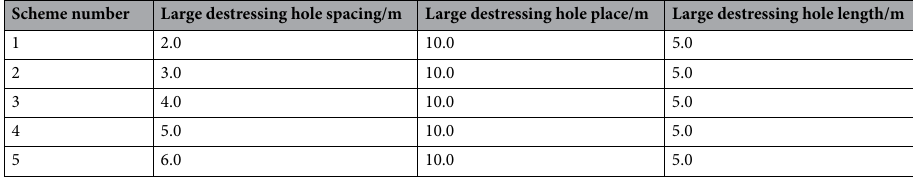
Table 4. Simulation scheme under different spacing